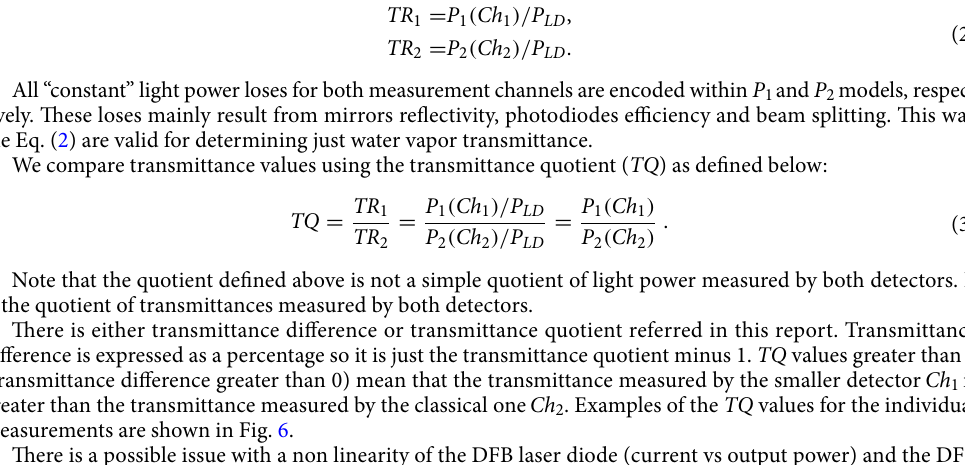
beam that has passed through the medium divided by the power of the light that has entered the medium. The characteristics of the detectors calculated above allow for calculating the transmittance for each of the channels: